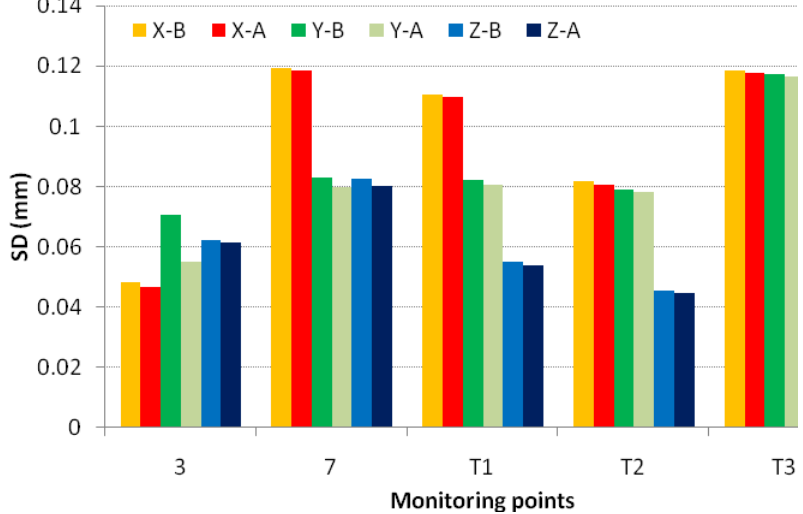
Figure 4. GPS standard deviation of three direction measurements before (B) and after (A) WT